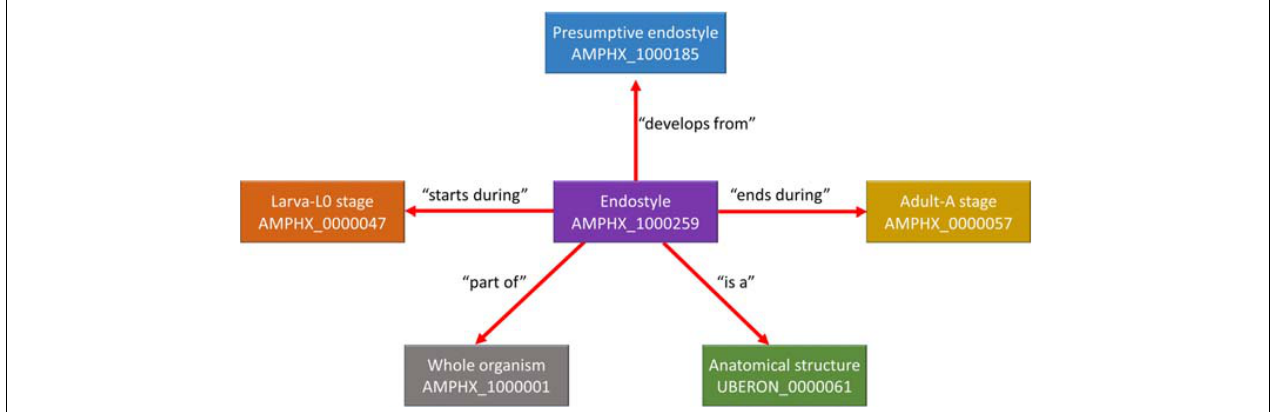
FIGURE 3 | Example for the representation of a structure-based subclass hierarchy in the amphioxus ontology (AMPHX). Using the amphioxus endostyle as an example, the partonomy relationships between different terms (“part_of”, “develops_from”, and “is a”) as well as the developmental stages during which the structure is present (“starts during” and “ends during”) are shown. The figure has been adapted from the Graph view utility proposed at OLS (Côté et al.,